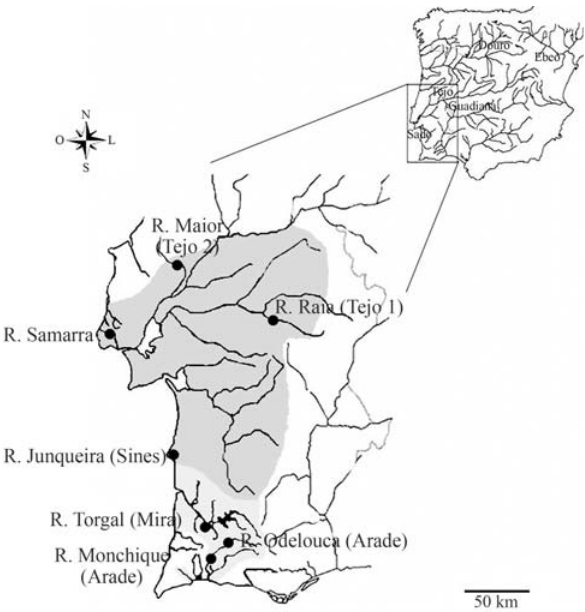
Figure 1 - Sampling localities in each drainage and geographic distribu- tion of Iberochondrostoma lusitanicum (dark grey - Samarra, Tejo and